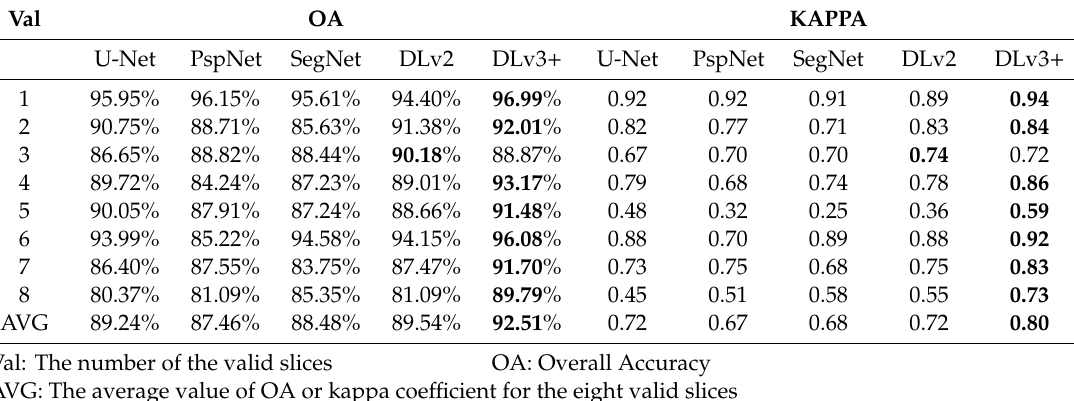
Table 3. Comparisons of U-Net, PspNet, SegNet, DeepLabv2 (DLv2), and DeepLabv3 + (DLv3 + ) on pixel-wise classification.